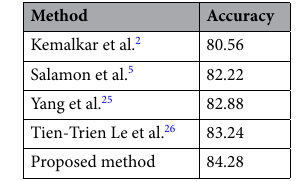
Table 4. Comparison of accuracy of engine sound under different operating conditions as obtained by different methods